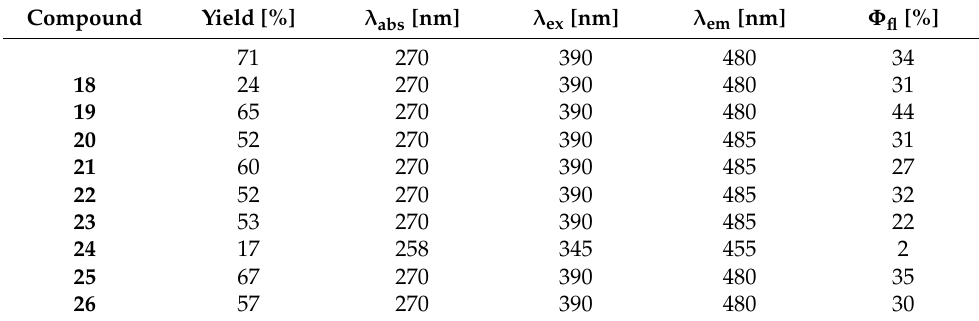
Table 3. Fluorescent properties of aminopyridines